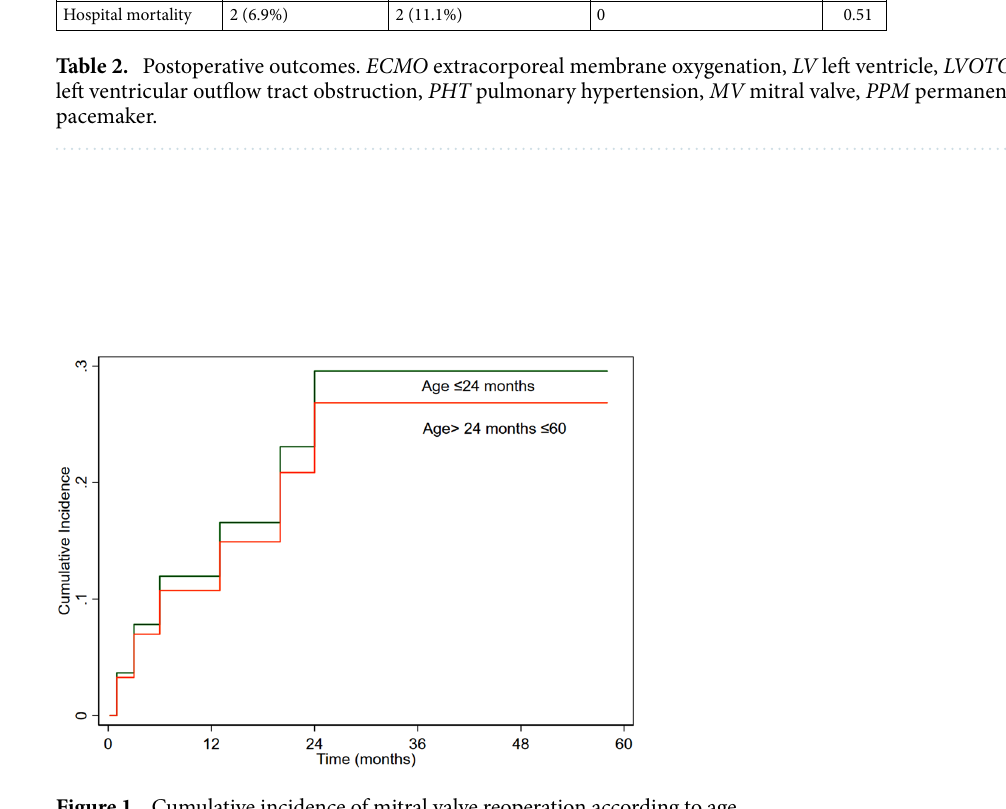
Figure 1. Cumulative incidence of mitral valve reoperation according to